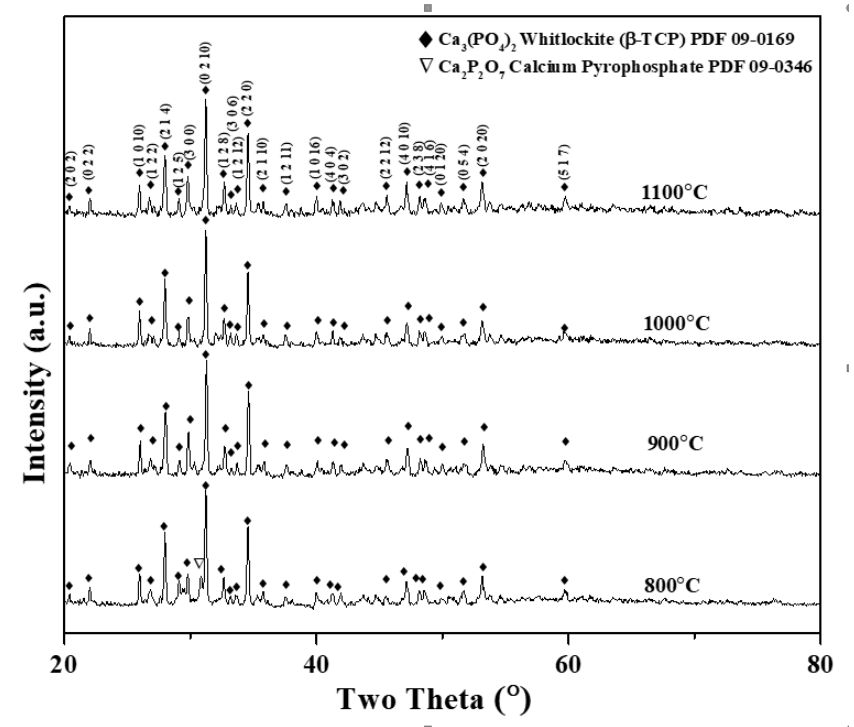
Figure 1. XRD patterns of β -TCP powders calcined at temperatures of 800, 900, 1000, and 1100 °C.